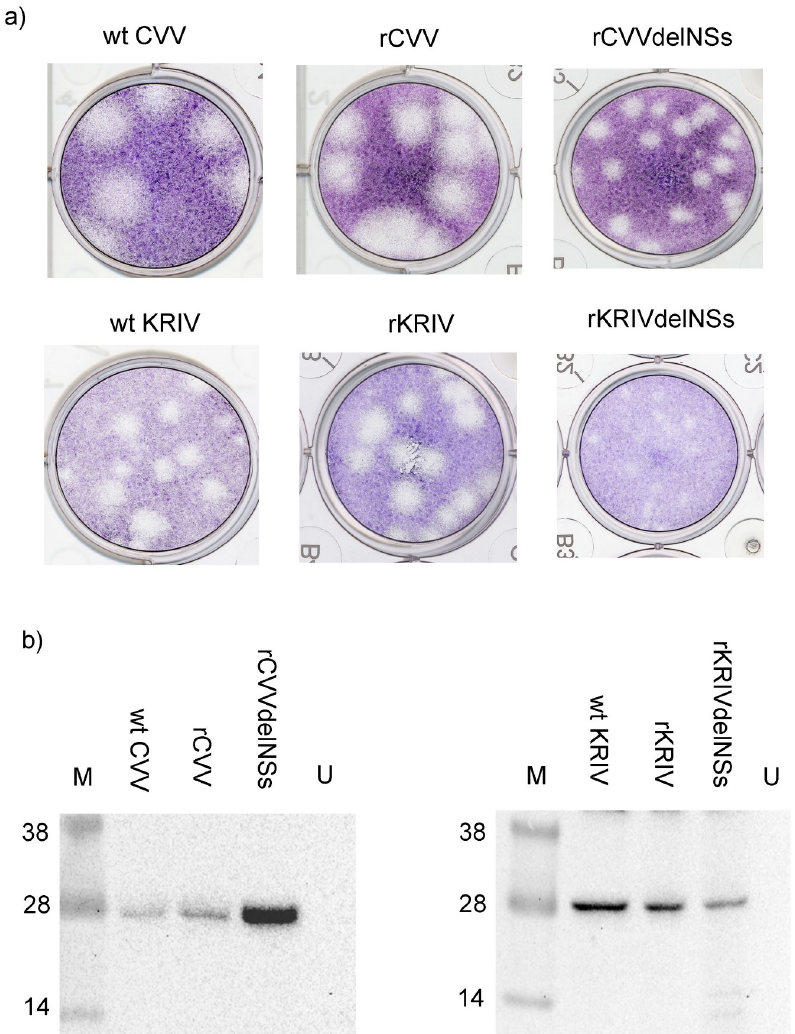
Fig 1. Growth of CVV and KRIV. (a) Plaque phenotype of authentic wt CVV and KRIV denoted as wt CVV and wt KRIV; recombinant wt CVV and KRIV, denoted as rCVV and rKRIV and NSs-deletant CVV and KRIV, denoted as rCVVdelNSs and rKRIVdelNSs. BHK-21 cells were used in all plaque assays. The plaque pictures shown are representative of several plaque assays. (b) Western blot analysis showing reactivity of infected BHK-21 cell lysate with anti-KRIV N and anti-CVV N antibodies. Molecular weight markers (M) in kD. The blot shown is a representative of 3 experiments with identical results; U, uninfected cells.